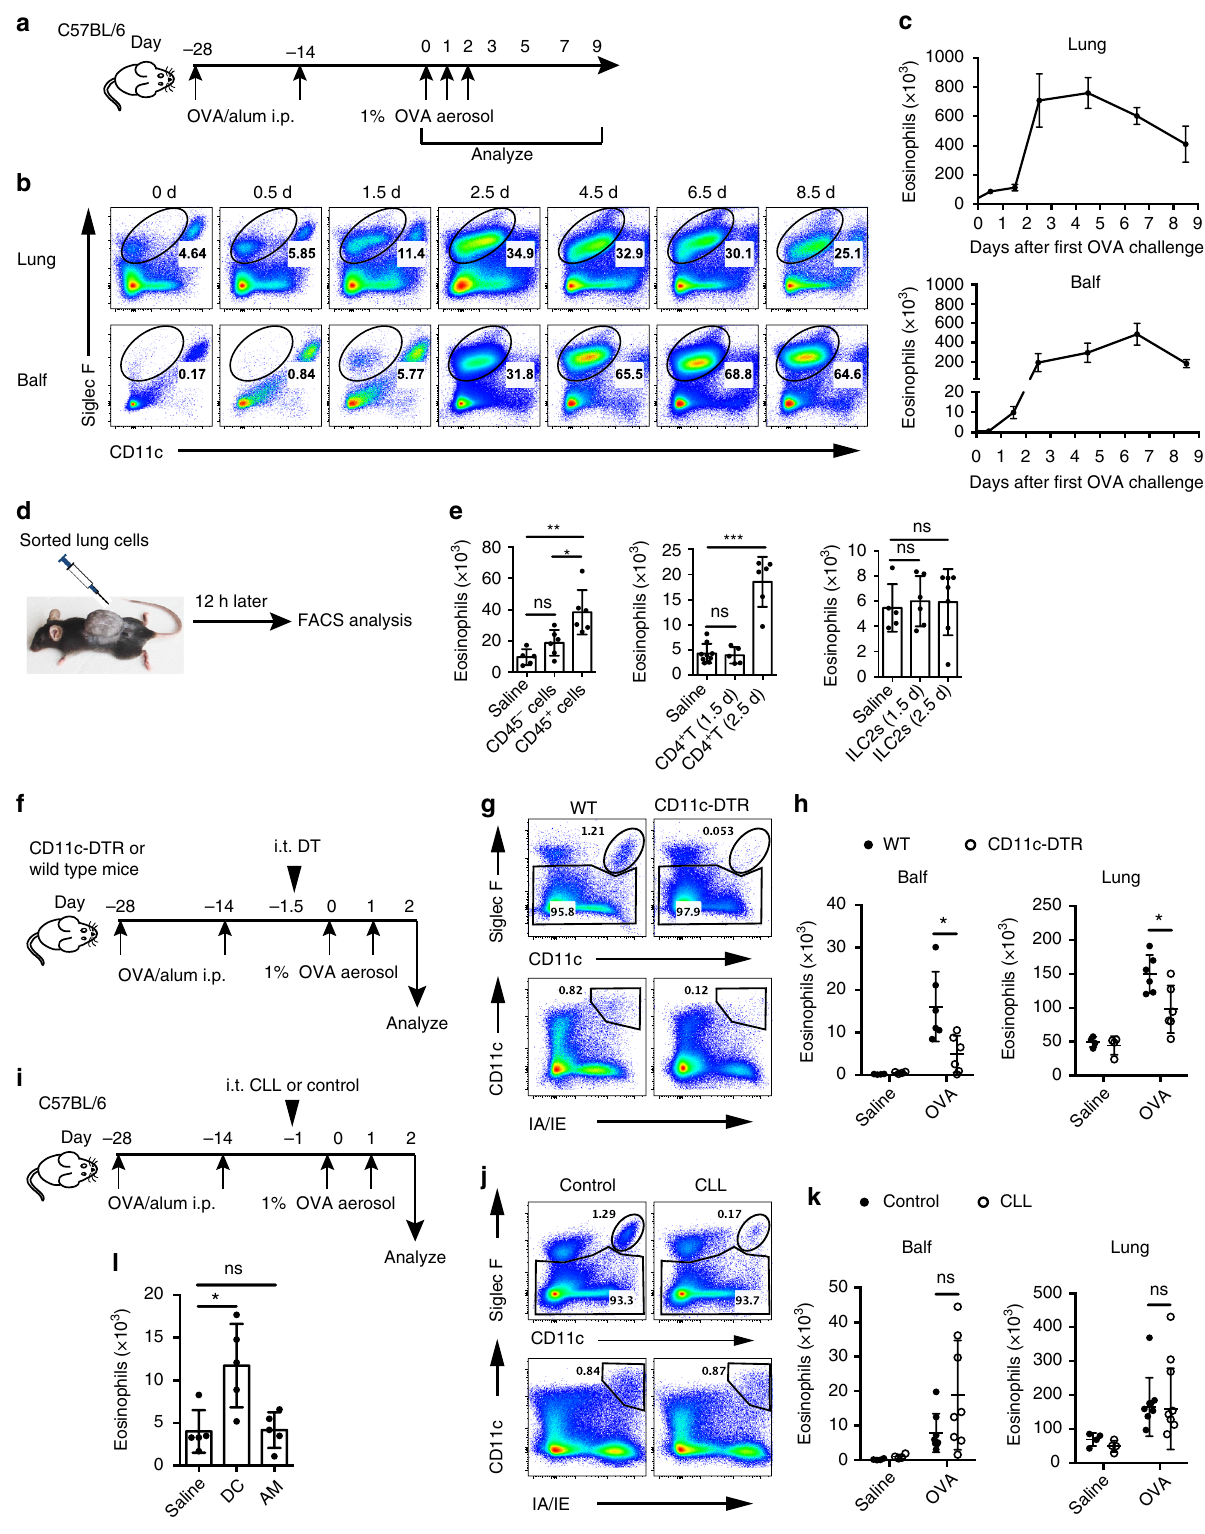
Sorted lung cells